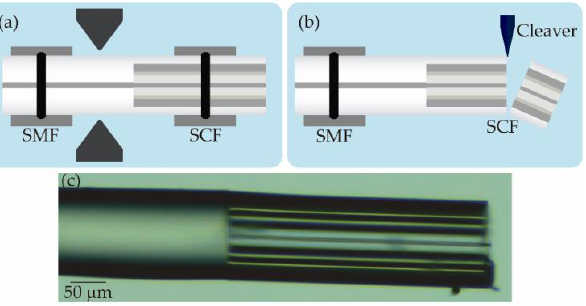
Figure 2. Schematic representation of the sensor fabrication process: ( a ) SMF and SCF samples spliced by electric arc discharges; ( b ) Cleaving of the SCF; ( c ) microscope photograph of the final sensor, with a SCF length of 365 µm.